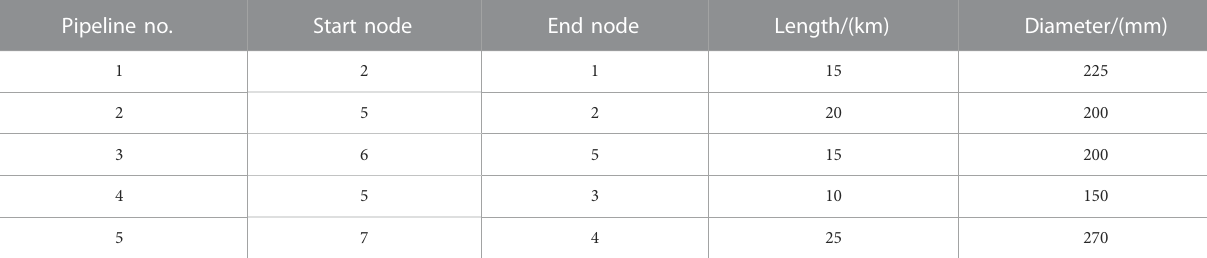
TABLE 3 Natural gas pipeline parameters.